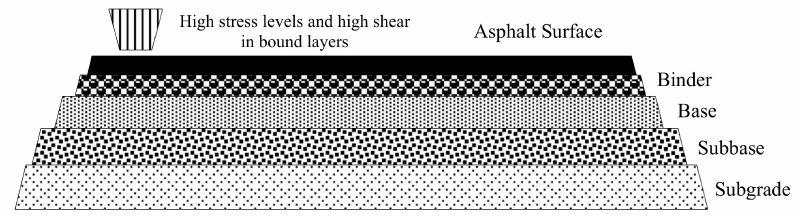
Figure 1. Pavement profile of a high-volume road